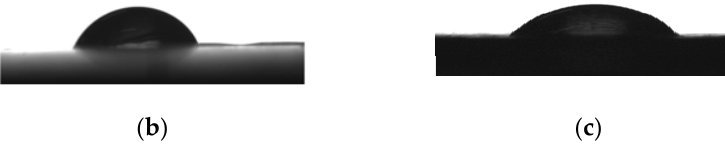
Figure 4. Droplet shape for ( a ) unaged, ( b ) CuSO 4 , and ( c ) hydrothermally aged